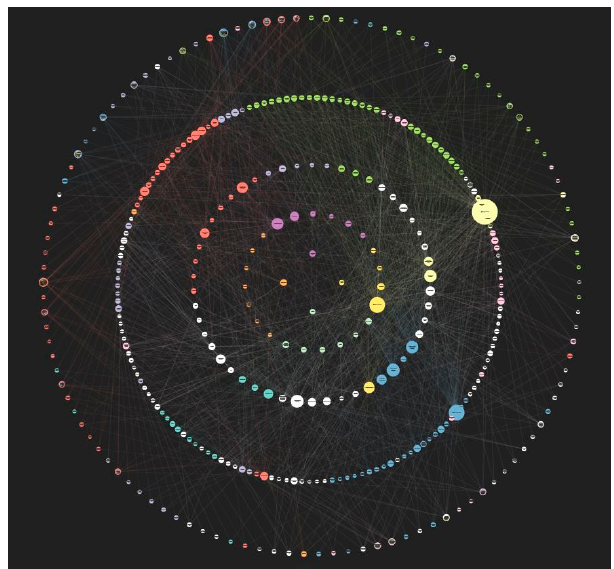
Figure 2. Screenshot of the ‘strategies for designing urban ecosystem services’ diagram version 1.0.